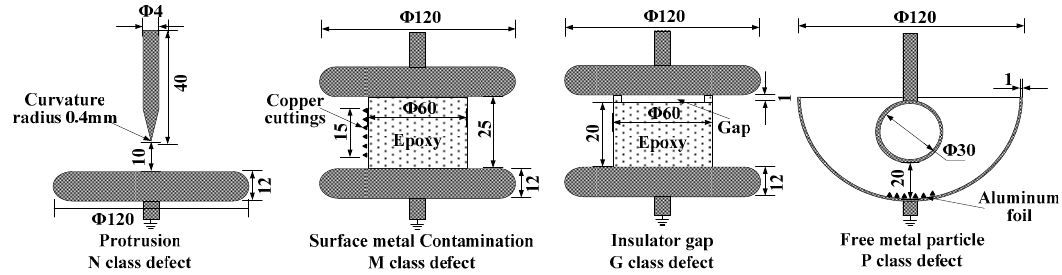
Table 1. PD experimental voltages.